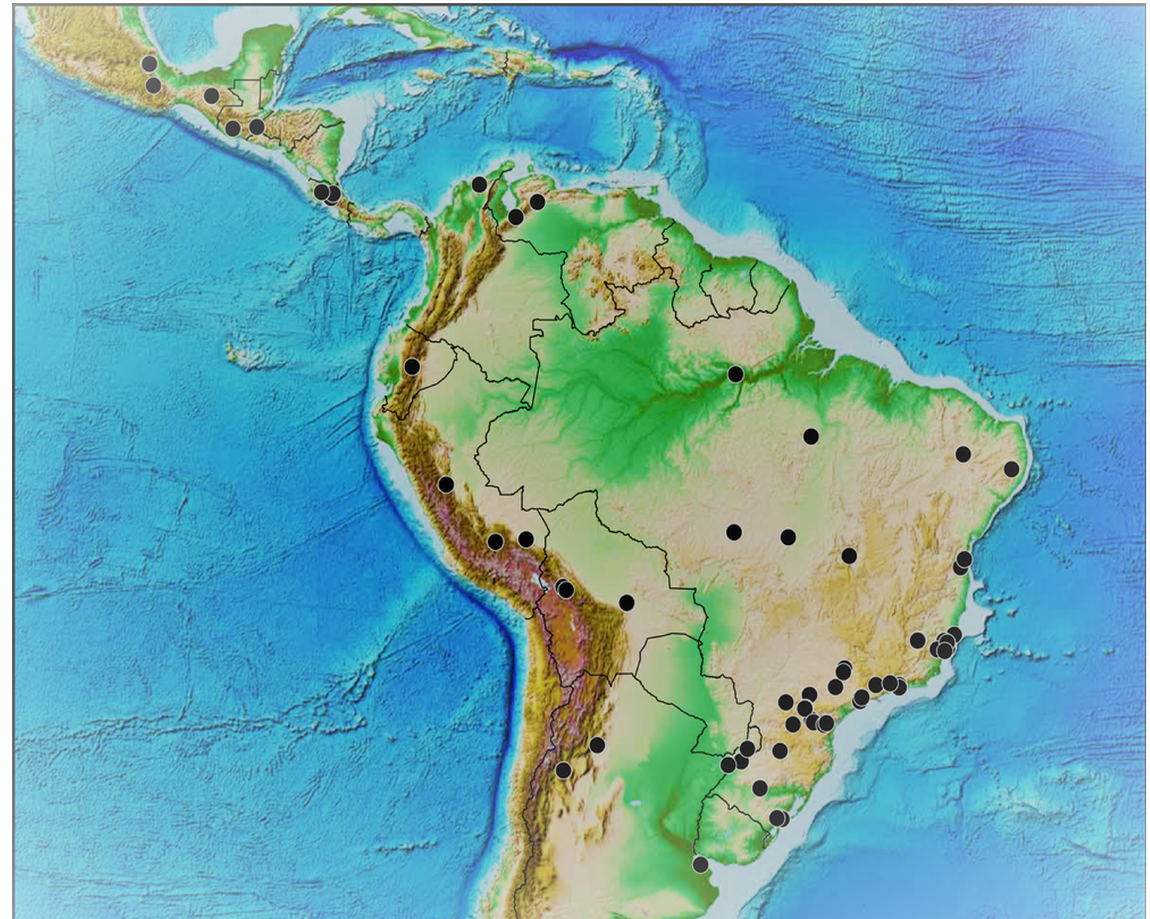
Fig. 17. Distribution records for Distictus spp., all records combined. Terrain + vegetation